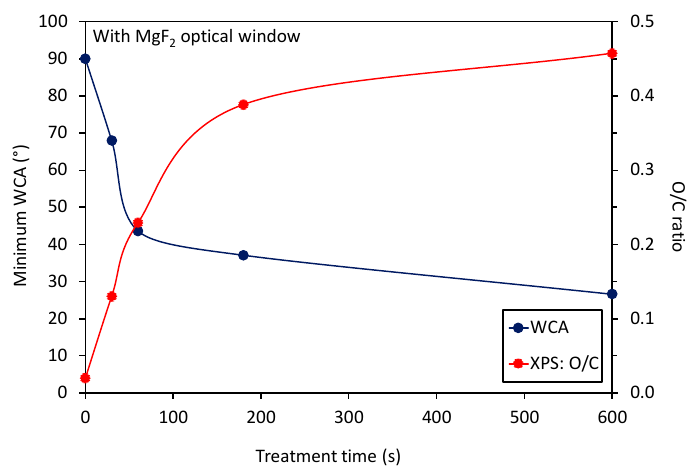
Figure 3. Variation of the minimum water contact angle and O/C ratio versus treatment time for the case when samples were covered with the optical window.